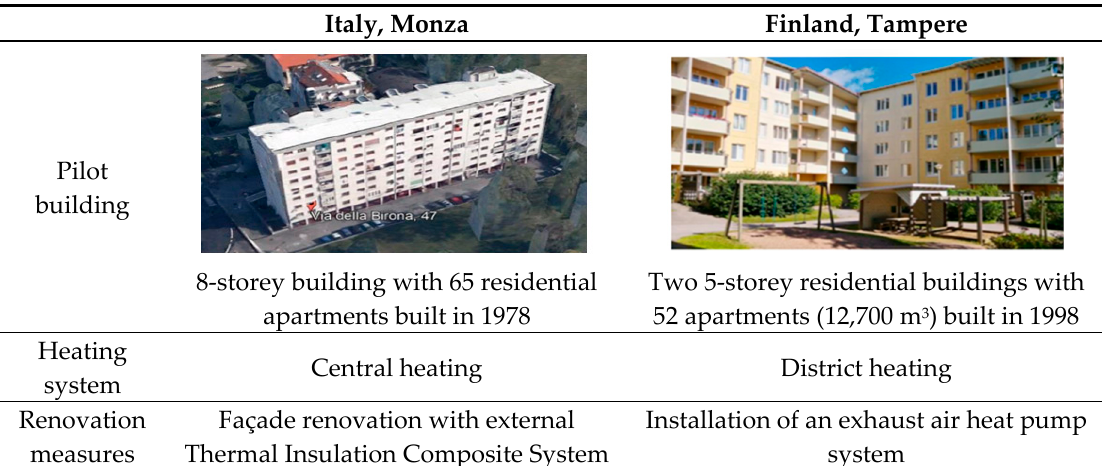
Table 1. The details of the demonstration